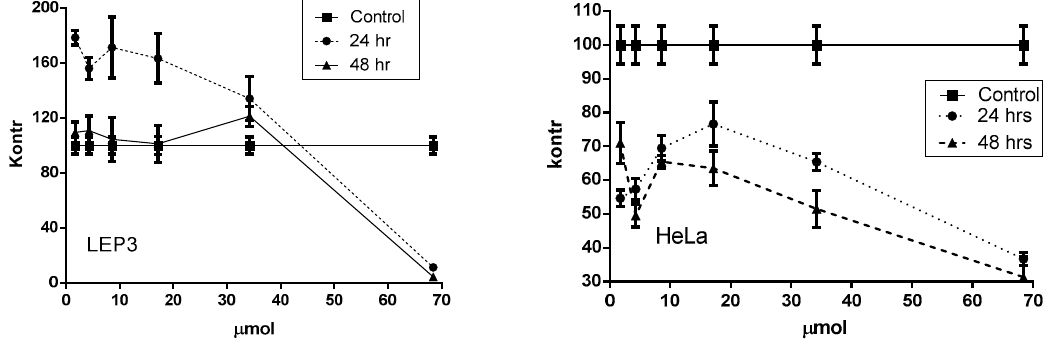
Figure 8. The viability of tumor (HeLa) and non-tumor (Lep-3) human cells cultured for 24 h and 48 h in the presence of Zn 4 (D16)(NO 3 ) 8 .